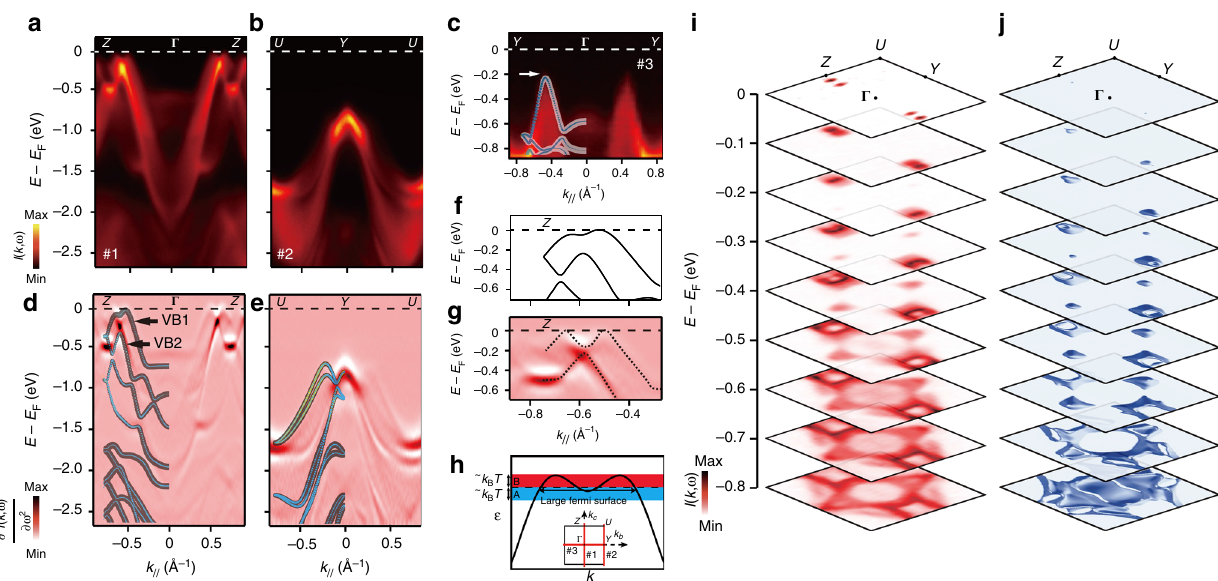
Fig. 2 ARPES resolved electronic structure of p-SnSe. ARPES measures band dispersions along high-symmetry directions of Z – Γ – Z a , U – Y – U b , and Y – Γ – Y c , taken with 50 eV photon energy. The second derivative plots d and e , corresponding to a and b , respectively, are directly compared with the DFT calculations, in which the weight of Sn 5 s and Se 4 p orbitals are represented by light blue and yellow colours, respectively. A close-up of the top VBs along Γ – Z reveals pronounced differences between the theoretical band dispersion f and the ARPES measured results g , as highlighted by the X-shaped dashed lines. h A schematic plot of a pudding-mould shaped VB with corrugations, which leads to giant S due to the band geometry effect. The inset of h indicates the ARPES cut directions in the projected two-dimensional fi rst Brillouin zone (BZ). i , j Comparison of stacked plots of constant energy contours at different E E > 0.2 eV. Black squares represent the boundary of the fi rst B , which show good agreement between ARPES and DFT when B